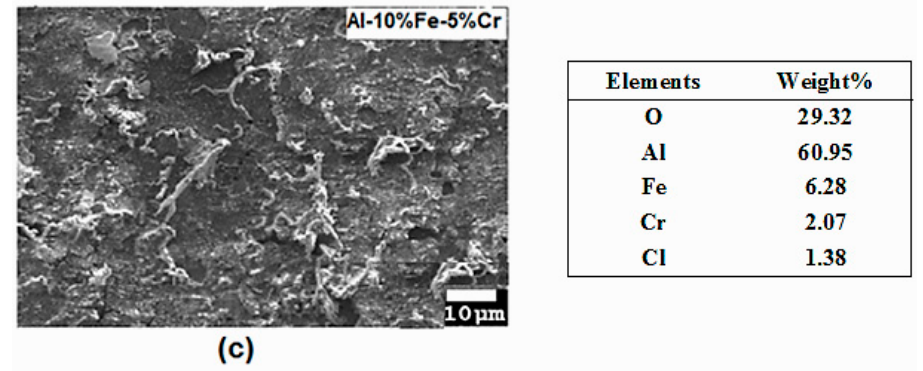
Figure 8. SEM micrograph and EDX profile analysis obtained on the ( a ) nanocrystalline Al, ( b ) Al ‐ 10% Fe and ( c ) Al ‐ 10% Fe ‐ 5% Cr alloy after its immersion in 3.5% NaCl for 1 h.